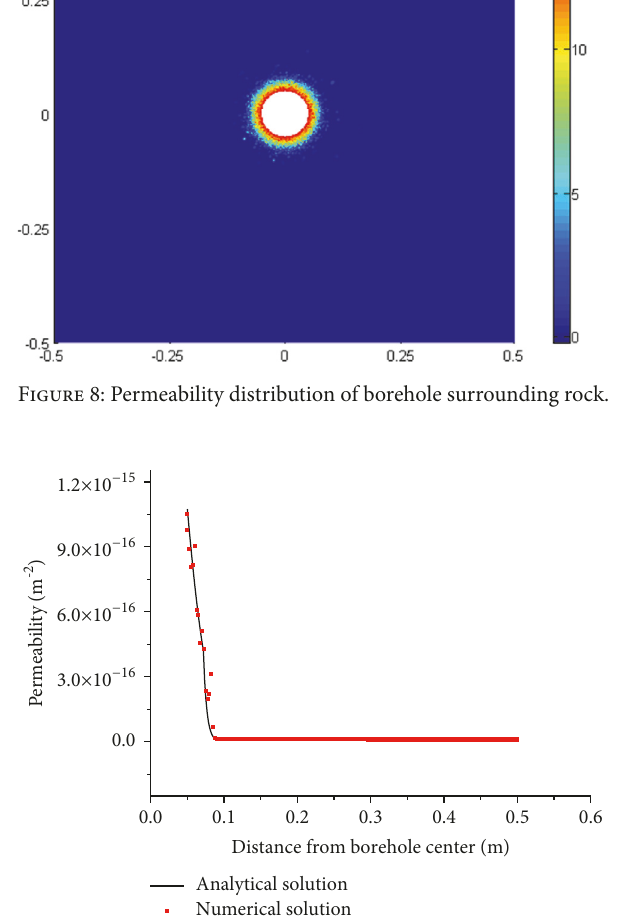
Figure 9: Comparison between numerical results and analytical results of